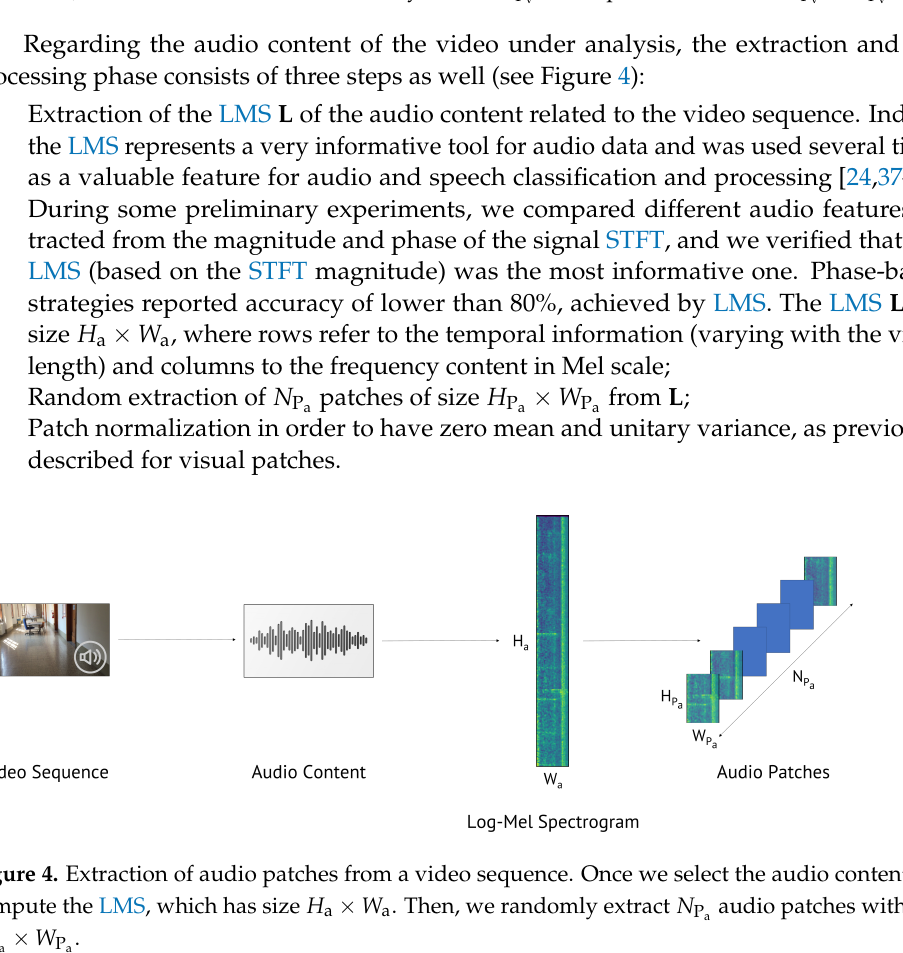
audio patches with size a